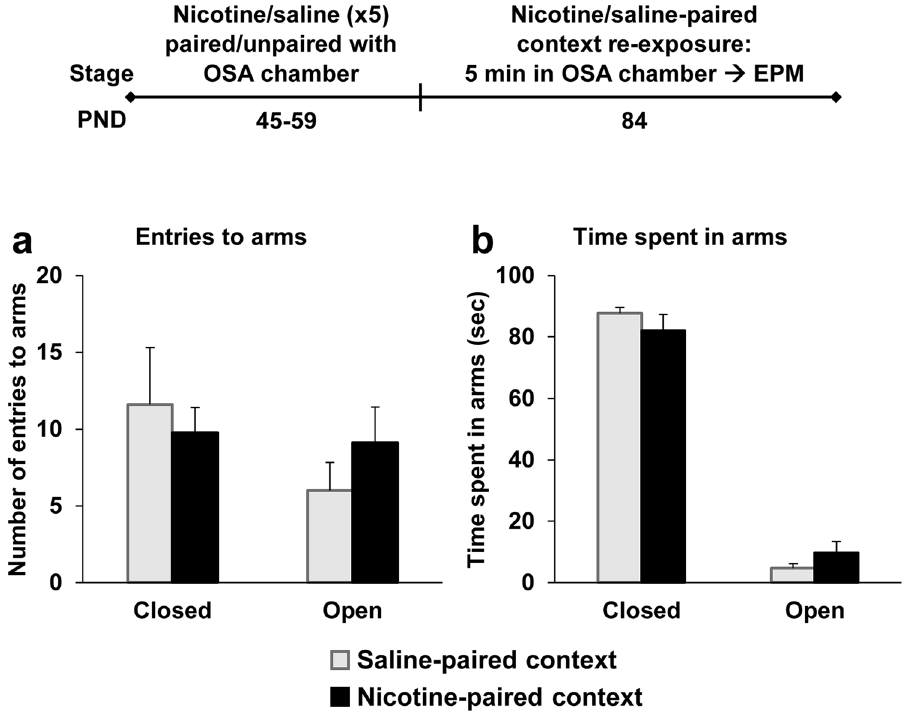
Figure 6. Re-exposure to nicotine-associated context does not evoke anxiety-like behavior. Rats were treated with 5 nicotine and saline injections on PND 45–59 either in the operant self-administration (OSA) chambers or in a different context. The OSA chambers were paired with nicotine treatment for the Nicotine-paired context group (rats received saline in the different context), or with saline for the control, Saline-paired context group (rats received nicotine in the different context). On PND 84, anxiety-like behavior was assessed by elevated plus maze (EPM) after a 5-min exposure to the OSA chambers (applying a re-exposure to the nicotine-associated context only for the Nicotine-paired context group, and re-exposure to the saline-paired context for the control group). ( a ) Entrance frequency to the closed or open arms of the maze. ( b ) Time spent in closed or the open arms. Bar graphs represent means ± SEM. All t(14) < 1.25, p’s > 0.05. n = 8 per